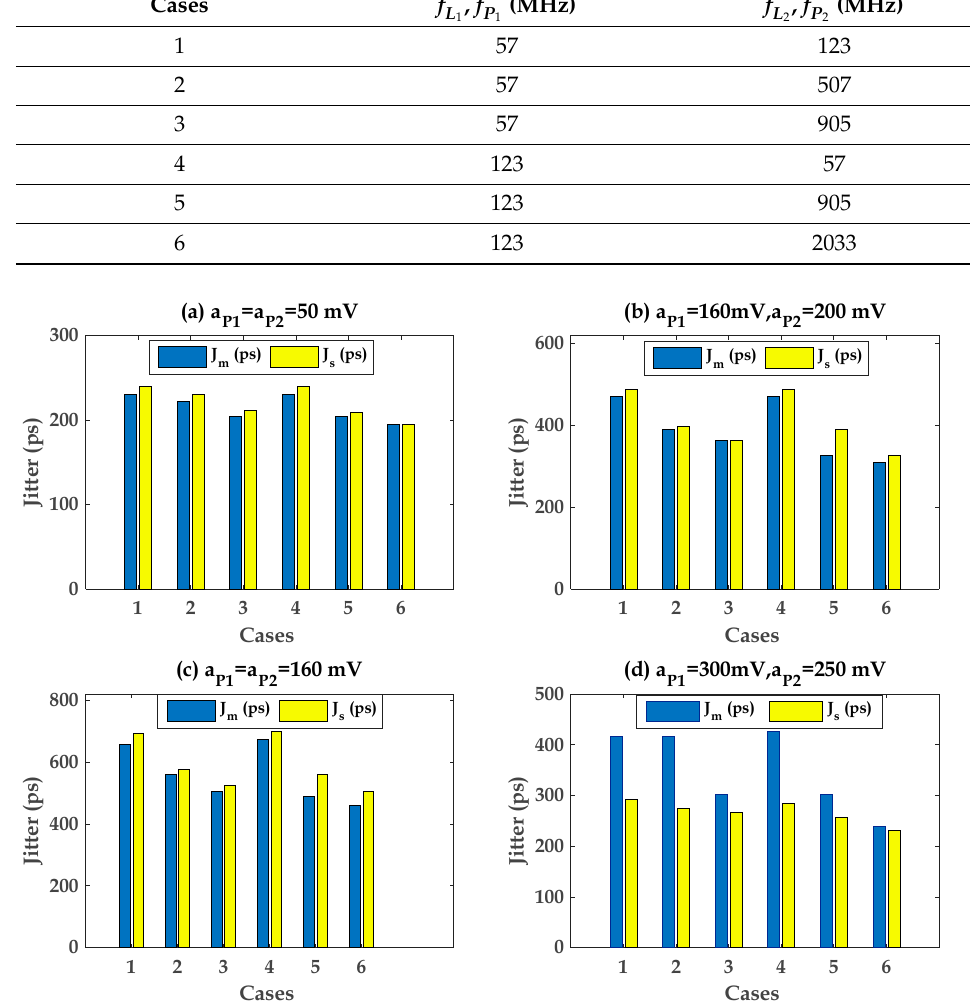
Figure 15. Pre-driver stage case: correlation between J m and J s based on the superposition of (9): ( a – c ): small-signal two tones. ( d ): large-signal case and ( d )